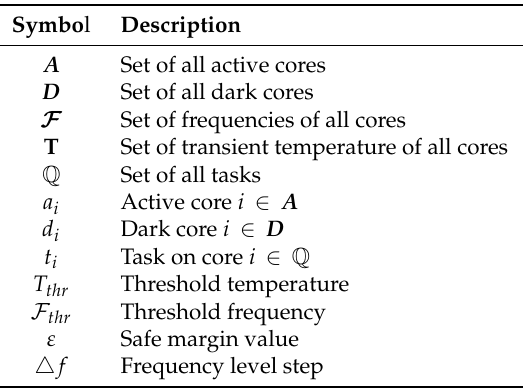
Table 1. The used symbols